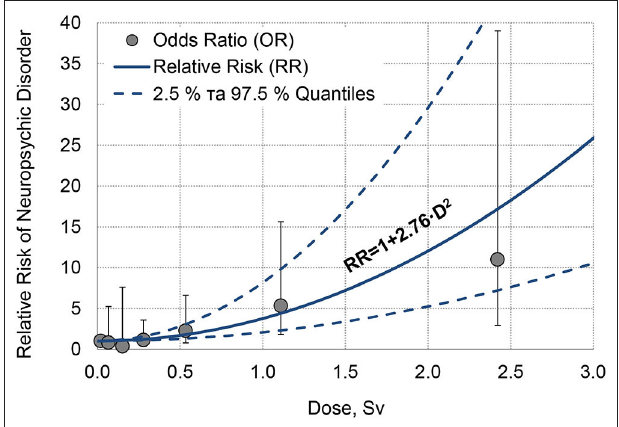
FIGURE 2 | Dose-response dependence on neuropsychiatric disorders in